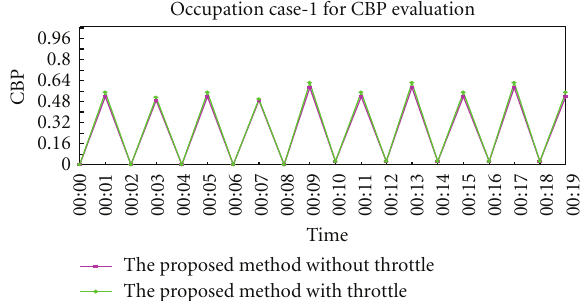
Figure 12: Comparison of CBPs without and with throttle for occupation